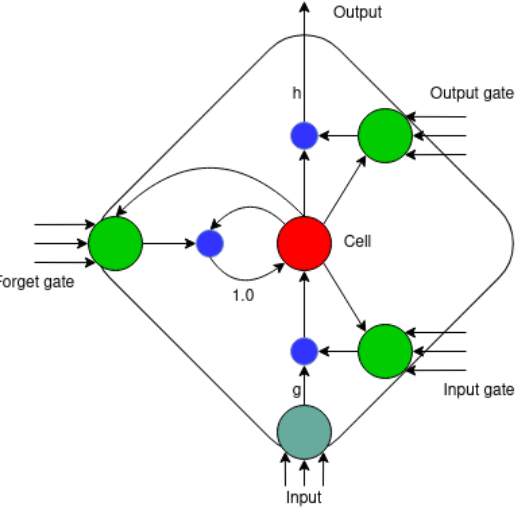
Figure 2. A memory block with a cell. The inner state is held with a connection of fixed weight 1. The three gates collect activation from inside and outside the block and control the cell through the multiplicative units, represented as smaller blue circles. The input and output activation functions of the cell are represented as h and g . Source: adapted from